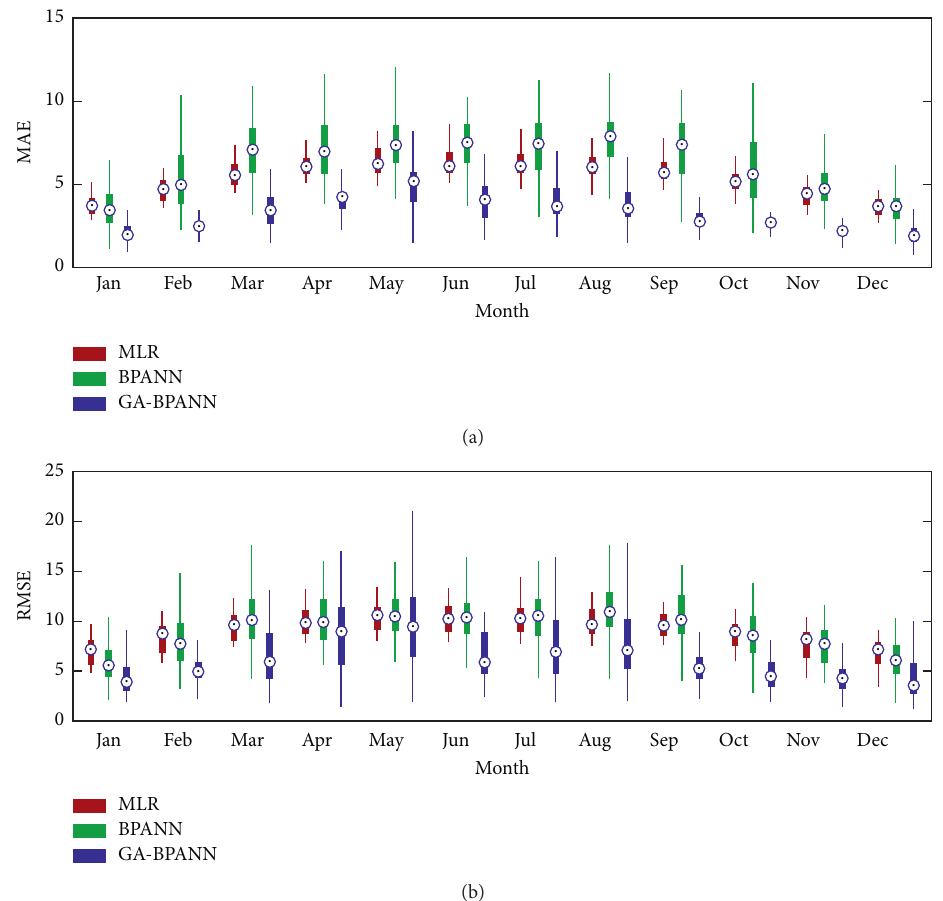
Figure 4: Boxplots of the monthly mean absolute errors (MAE) and root-mean-square error (RMSE) of the three interpolation methods for estimating monthly Antarctic SAT during 1960–2019 obtained from the